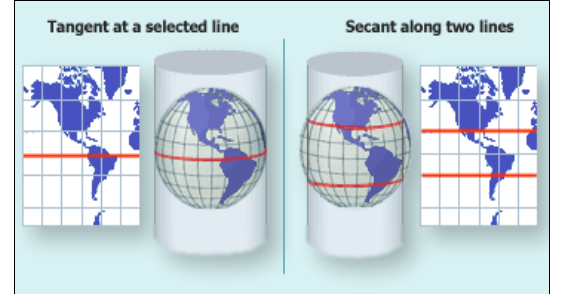
Figure 2: Cylindrical projections with tangent or secant